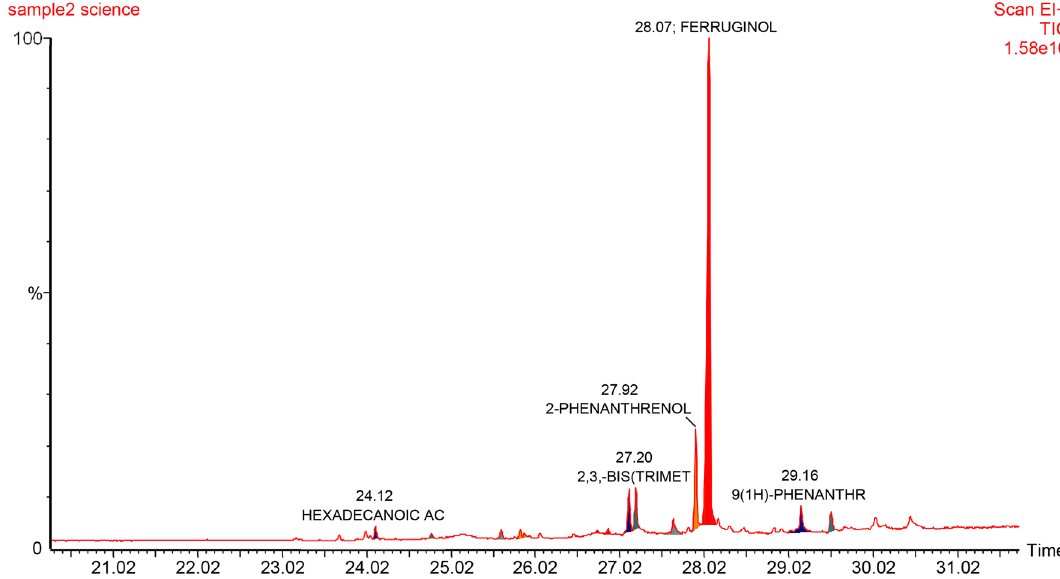
Figure 9. GC–MS analysis chromatograms of callus of J. procera under treatment of ZnO NPs (160